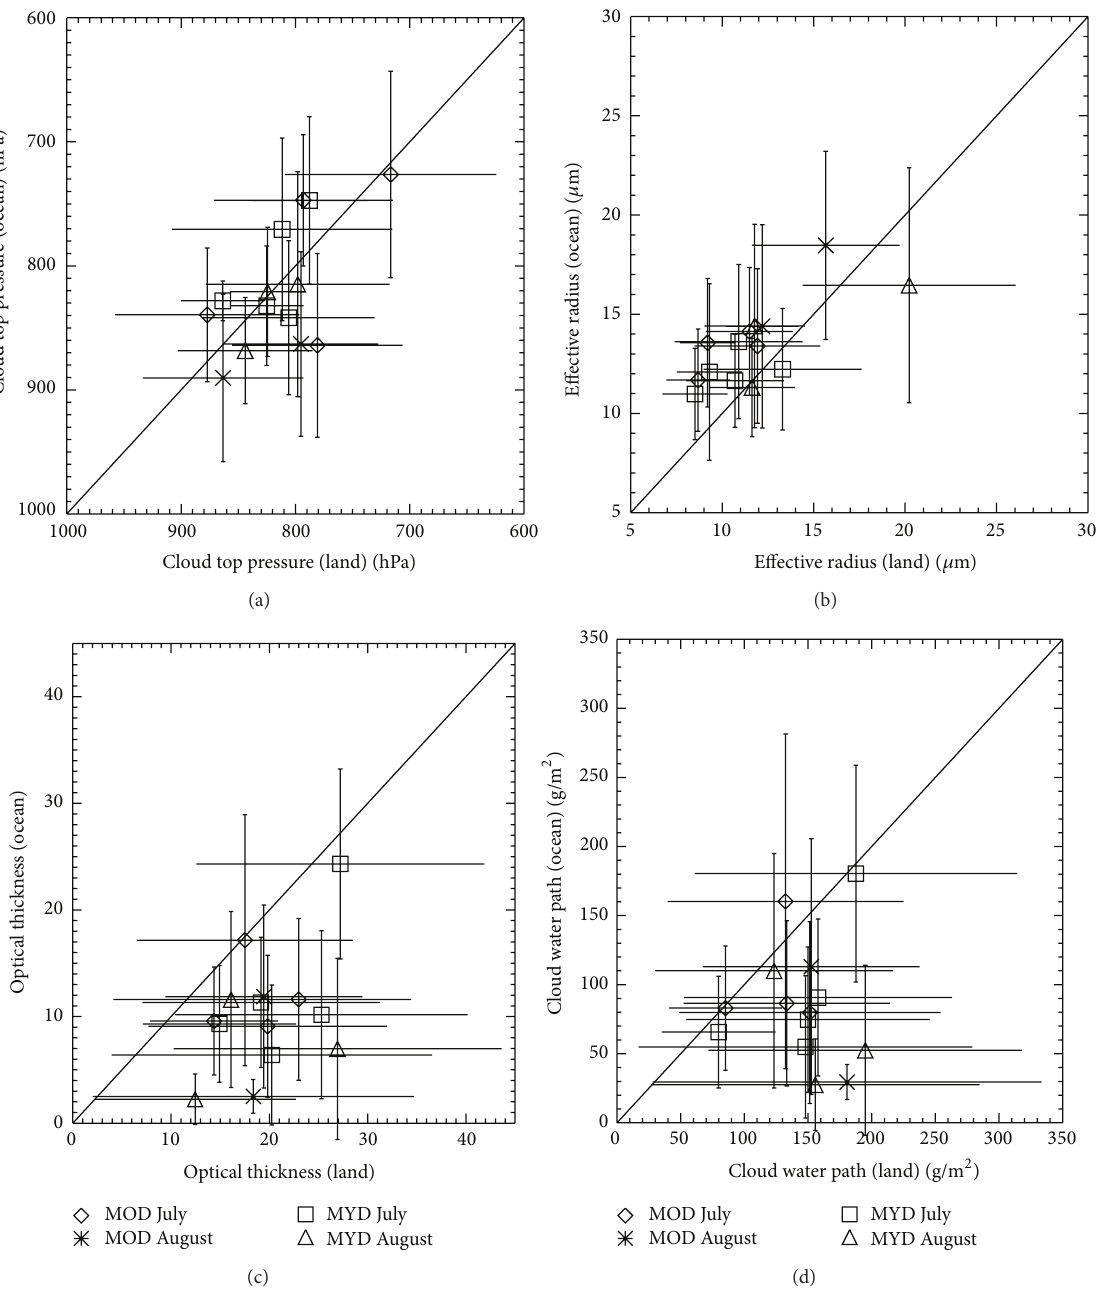
Figure 14: Scatter plots of cloud top pressure (a), effective radius ( 𝑟 𝑒 ) (b), optical thickness ( 𝜏 ) (c), and cloud water path (d) over land and ocean based on the 12 cases of lower-level cloud in the two periods (end of July and middle of August) detected by the MODIS onboard the Terra and Aqua satellites. One-to-one lines are also plotted. Horizontal and vertical bars indicate standard deviations ( 1𝜎 ) of each parameter over land and ocean in the Sanriku area (black box, Figure 3(a)), respectively. Explanations of symbols are as shown in